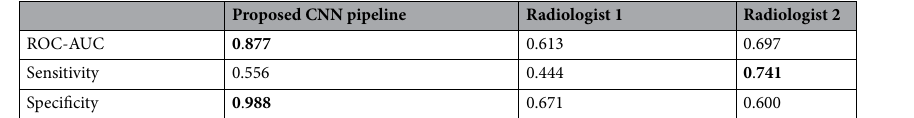
Table 2. Performance comparison between proposed CNN pipeline and two radiologists on PCa classification with CT scans. The bold element in each row indicates the strongest performing model for that row’s metric (ROC-AUC, sensitivity, and